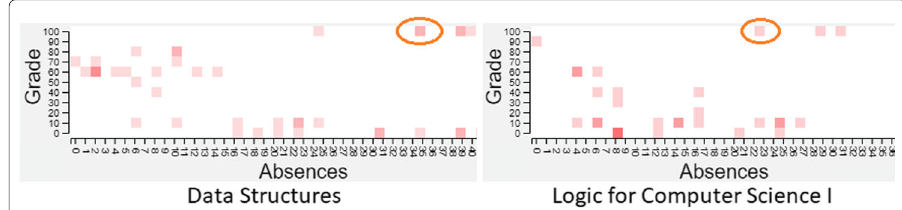
Fig. 11 Attendance vs. grade Heatmap Matrices for "Data Structures" and "Logic for Computer Science I", in which 18.18% and 28.57% of the students received high grades and had high number of absences,